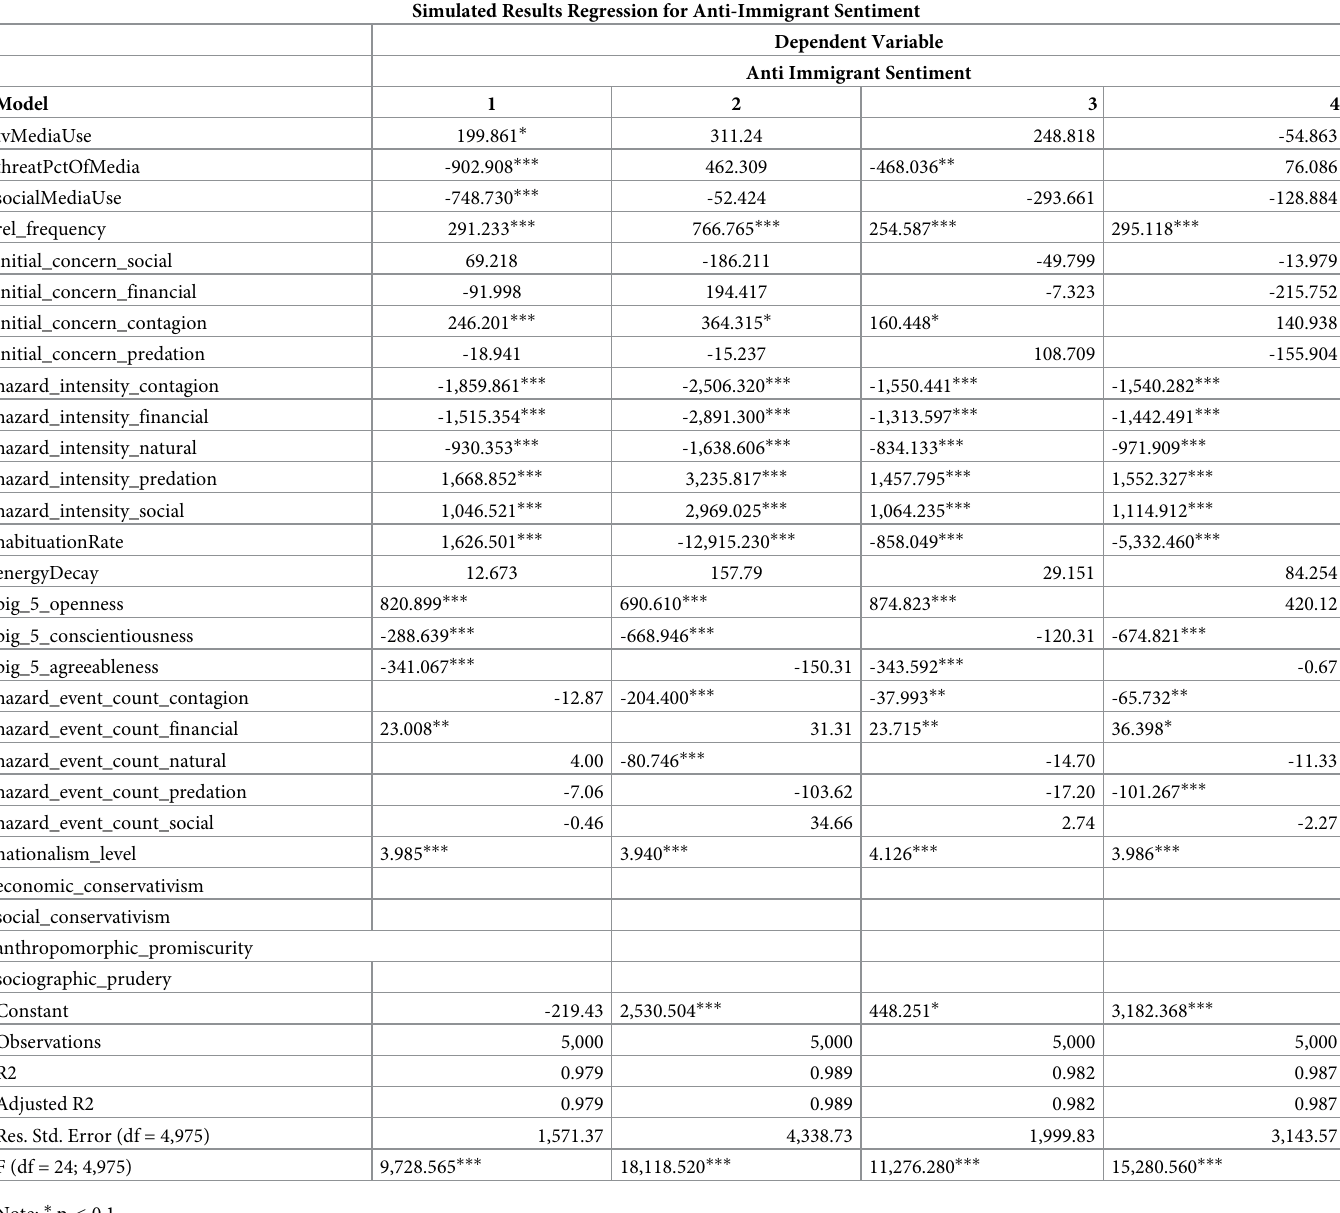
Table 10. Anti-immigrant sentiment as dependent variable in 4 regression models where data is drawn from simulations with low sociographic prudery (model 1), high sociographic prudery (model 2), low anthropomorphic promiscuity (model 3), and high anthropomorphic promiscuity (model 4). Simulated Results Regression for Anti-Immigrant